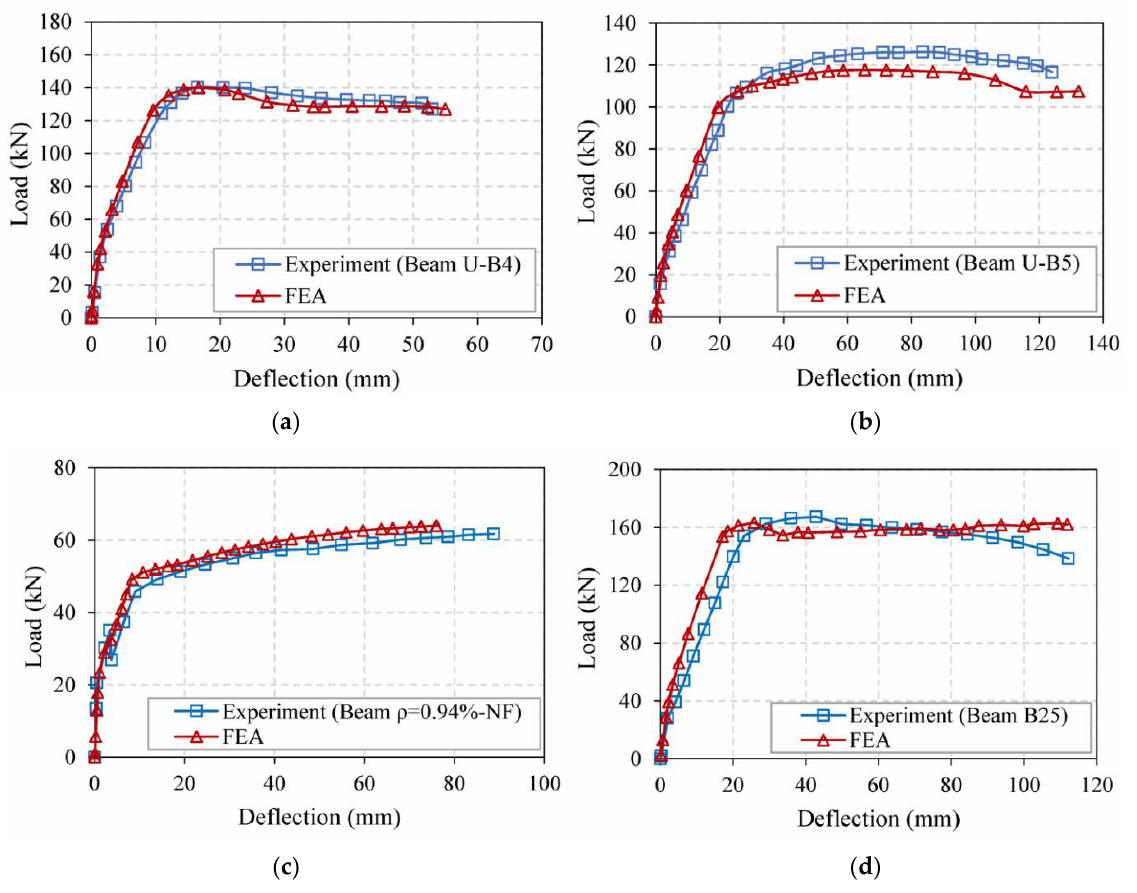
Figure 6. Comparison of load deflection behavior of UHPFRC beams under different loading conditions and with different fiber volume fractions. ( a ) U-B4 under shear dominant loading. ( b ) U-B5 under flexural loading. ( c ) UHPC beam ( 𝜌 = 0.94%-NF) [11]. ( d ) UHPFRC beam (B25) [34].